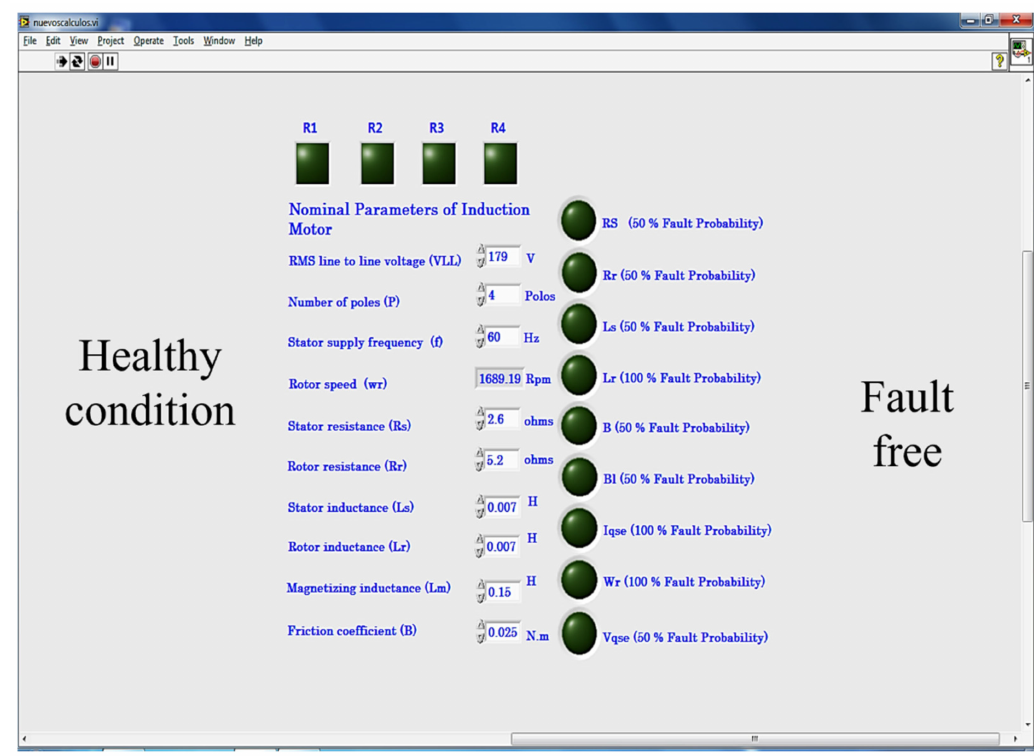
Figure 11. Screen of HMI for the 3PIM fault detection in the fault-free case.